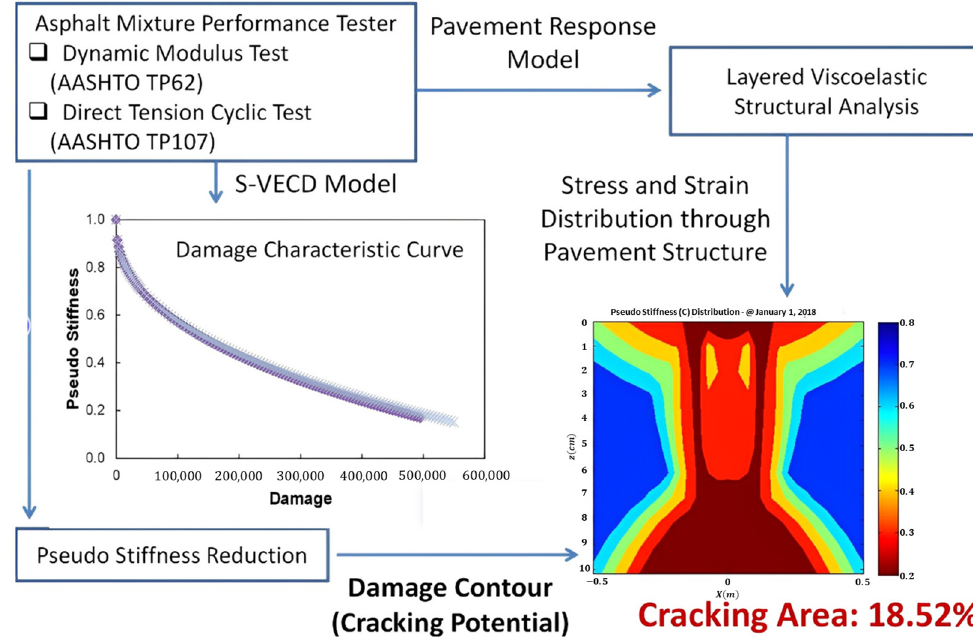
Figure 4. Mechanistic fatigue cracking area prediction method.